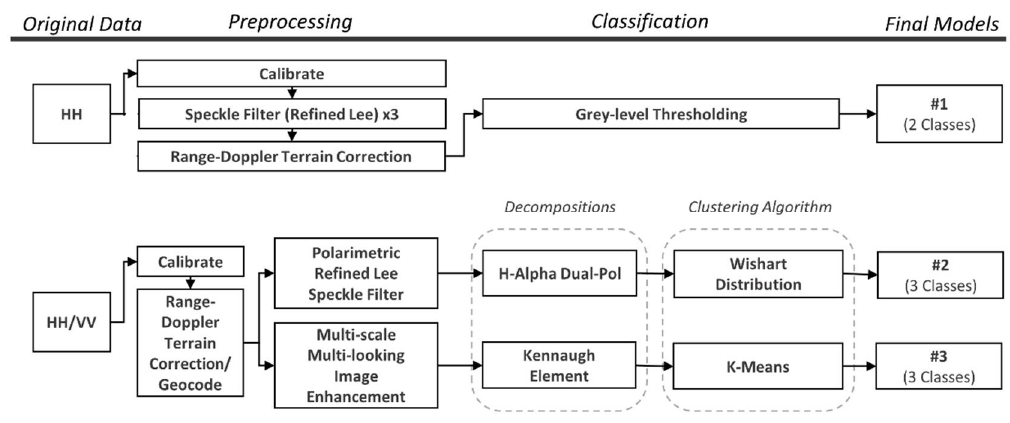
Figure 3. Processing workflow for single- and dual-polarization data to create three final models for each TerraSAR-X (TSX) scene.